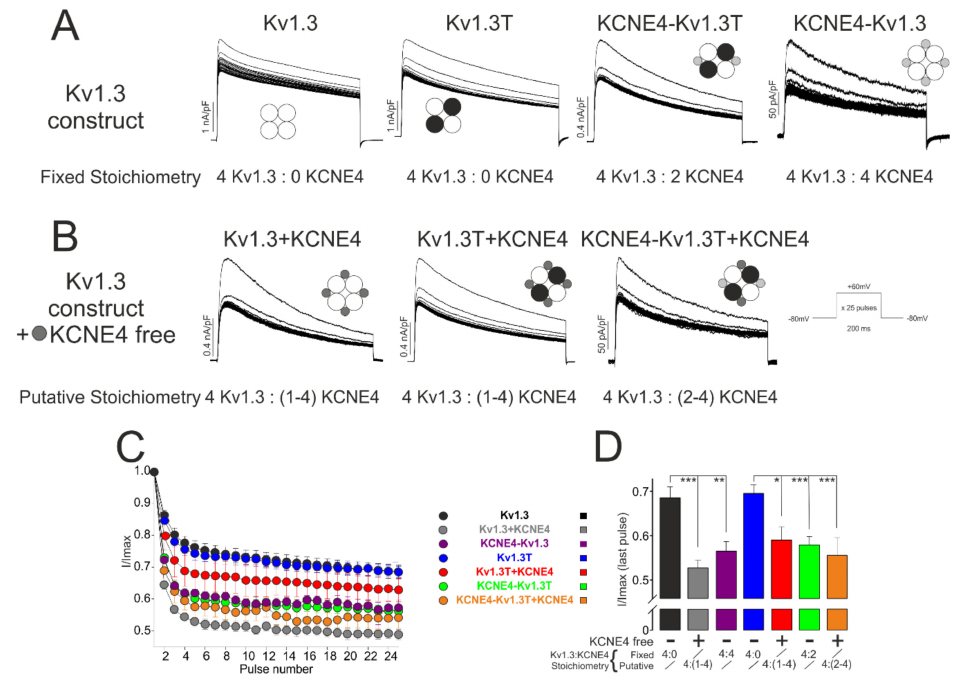
Figure 6. Analysis of the cumulative inactivation. HEK-293 cells were transfected with di ff erent Kv1.3-KCNE4 constructs, and K + currents were analyzed. ( A ) Chimeras with fixed Kv1.3-KCNE4 stoichiometry. Kv1.3 (4:0), Kv1.3T (4:0), KCNE4:Kv1.3T (4:2), KCNE4:Kv1.3 (4:4). ( B ) Functional complexes with putative Kv1.3-KCNE4 stoichiometries due to further addition of extra free KCNE4 units. Kv1.3 + KCNE4: Kv1.3 in the presence of KCNE4 (4:(1–4)). Kv1.3T + KCNE4: Kv1.3T in the presence of KCNE4 (4:(1–4)). KCNE4-Kv1.3T + KCNE4: KCNE4-Kv1.3T in the presence of KCNE4 (4:(2–4)). Cells were held at − 80 mV, and a train of 25 depolarizing pulses to + 60 mV for 200 ms was applied. ( C ) I / Imax vs. the pulse number. The ratio of the peak current amplitude during each pulse relative to that during the 1st pulse (I / Imax) was plotted against every pulse. ( D ) I / Imax reached at the last pulse train of depolarization. * p < 0.05, ** p < 0.01, and *** p < 0.001 (Student’s t -test). Values are the means ± SE of n = 10–15. Kv1.3 (black); Kv1.3 + KCNE4 (gray); KCNE4-Kv1.3 (purple); Kv1.3T (blue); Kv1.3T + KCNE4 (red); KCNE4-Kv1.3T (green); and KCNE4-Kv1.3T + KCNE4